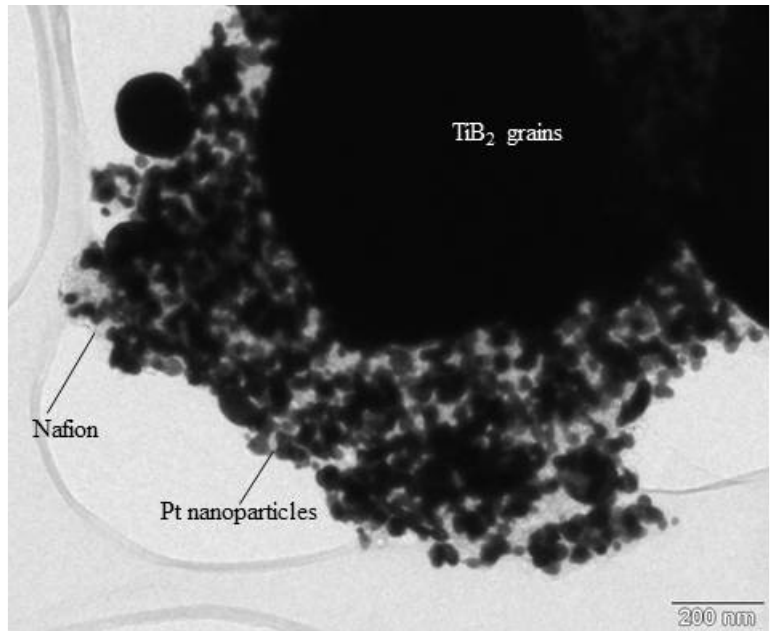
Figure 2. Transmission electron micrograph of Pt/TiB nanoparticles can only be imaged in thinner edge regions, as the μ m-sized TiB too thick to let electrons pass through the grain center. The average Pt particle size as ca. 5 nm embedded in a Nafion™ ionomer